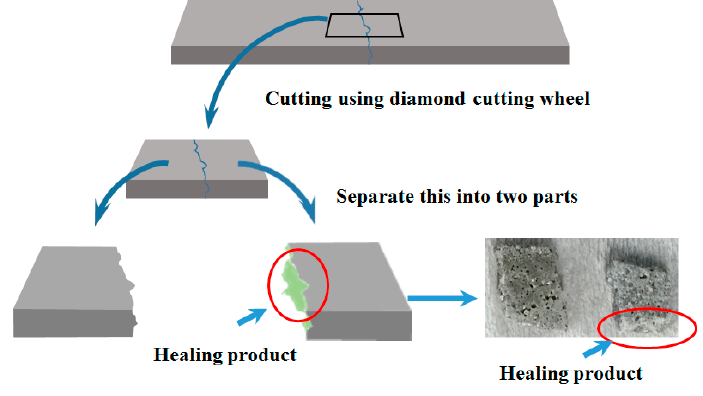
Figure 8. Samples for SEM.